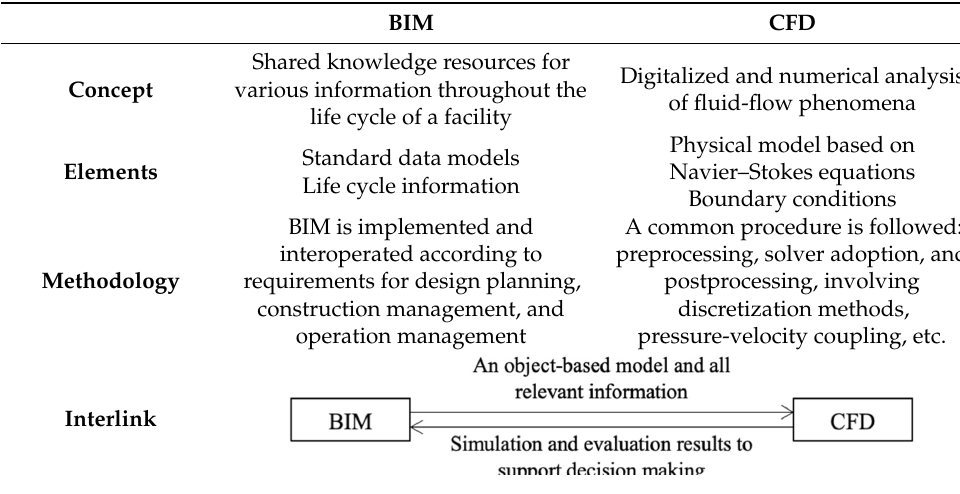
Table 1. Overview of BIM and CFD technology. BIM